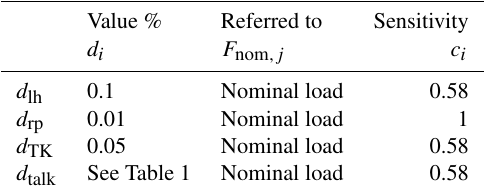
Table 1. Crosstalk of each nominal load F nom ,j on the nom- inal output signal S j of each measurement, and the combined crosstalk d talk .